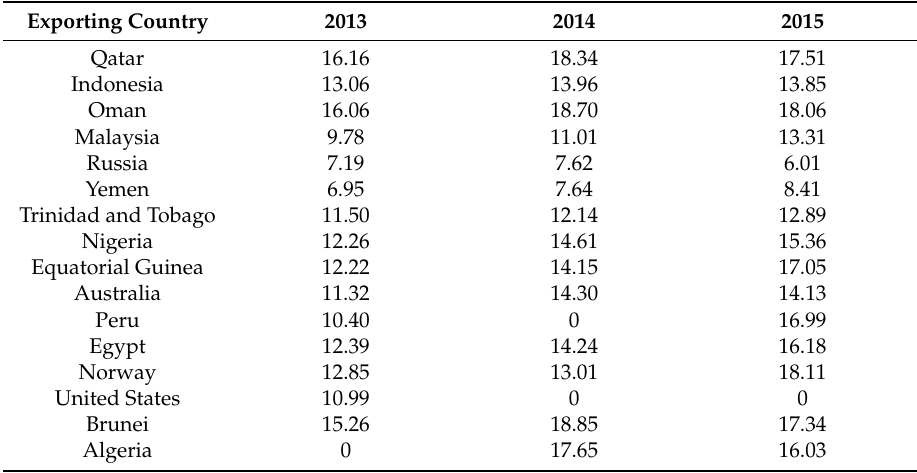
Table 4. LNG long-term contract prices for each exporting country